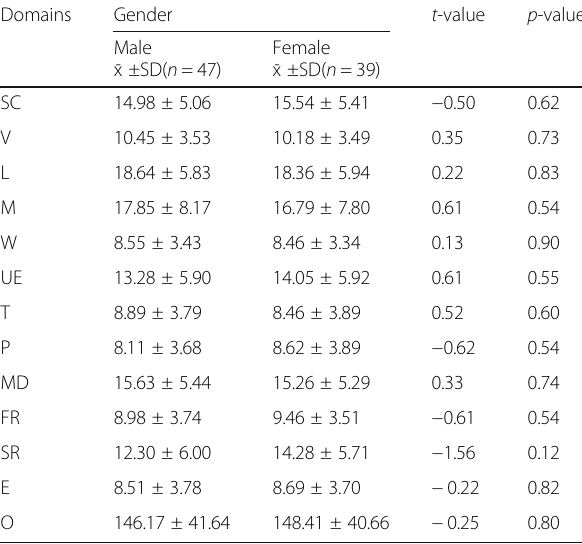
Table 5 Independent t-test comparison of domains and overall score of the Final Hausa version of the Stroke-specific Quality of Life Scale by